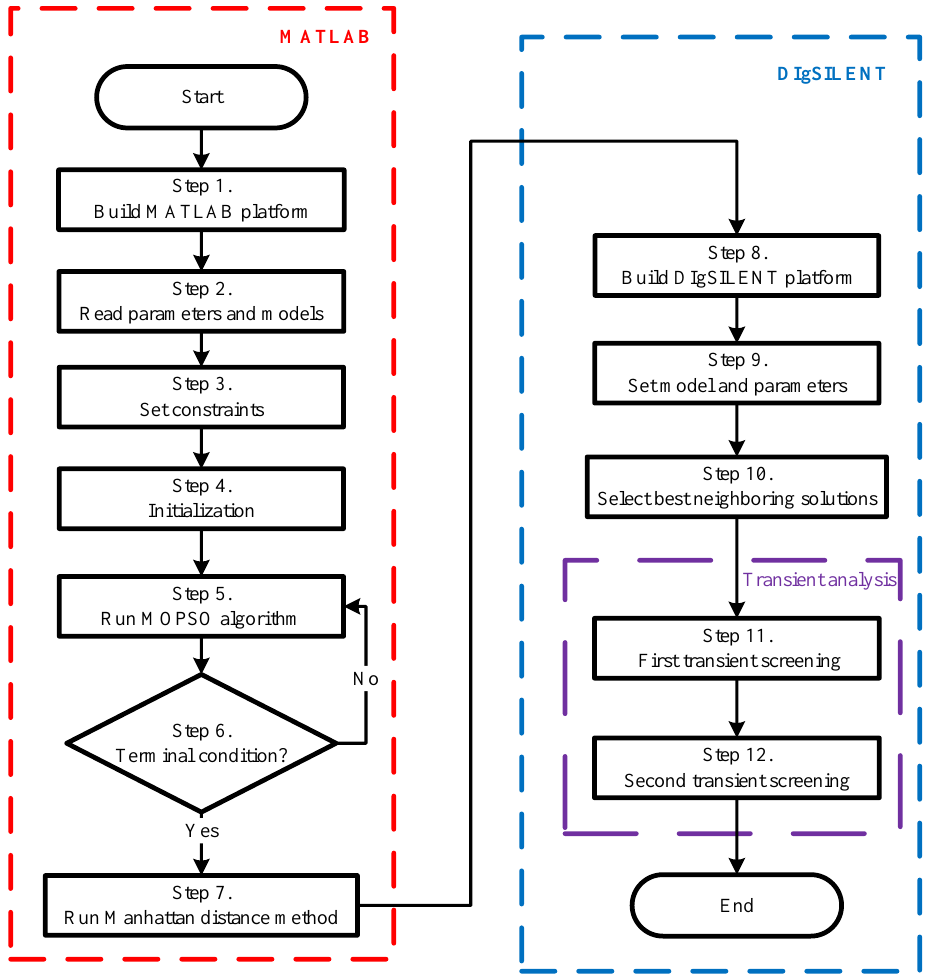
Figure 11. Flowchart of the proposed solution.